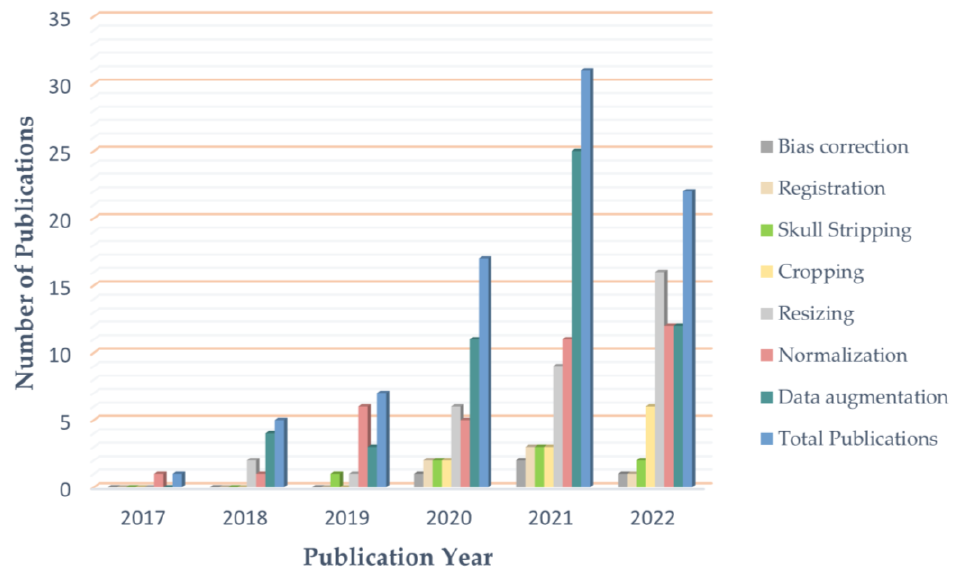
Figure 5. Usage of preprocessing techniques from 2017 to 2022.